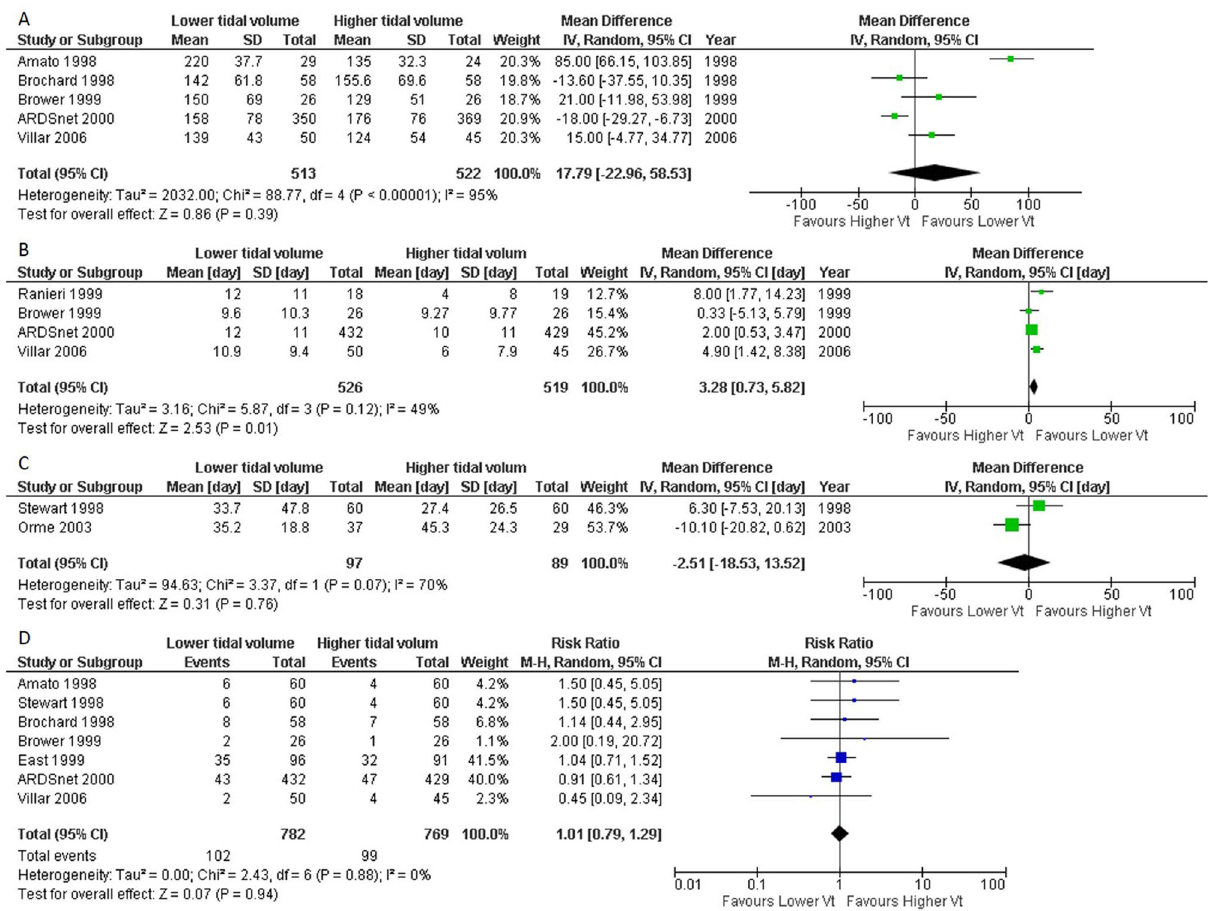
Figure 4. Forest plot showing the comparison of low tidal volume ventilation (LTV; 4–8 ml/kg) versus high tidal volume ventilation (HTV; > 8 ml/kg) for secondary outcomes. ( a ) PaO 2 /FiO 2 ratio on day 1. ( b ) Ventilator- free days up to 28 days. ( c ) Length of hospital stay, ( d ) Barotrauma CI confidence interval, IV inverse variance, M–H Mantel–Haenszel